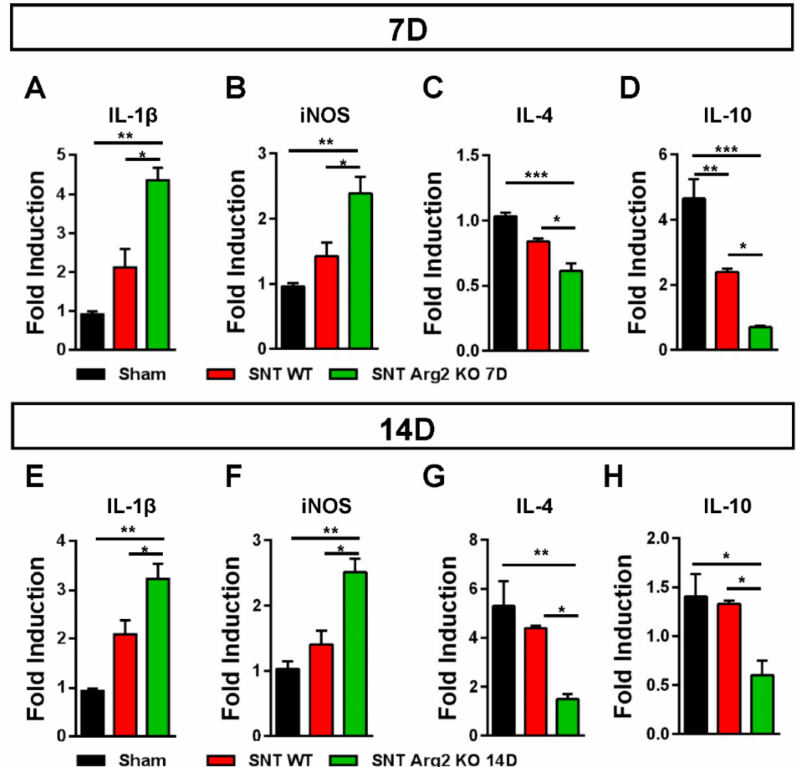
Figure 7. Regulation of inflammatory markers in the mice following the SNT surgery. ( A , B ) Gene expression levels of the pro-inflammatory markers interleukin (IL)-1 β and iNOS assessed by qRT-PCR indicated an upregulation of either IL-1 β or iNOS in the spinal dorsal horns of mice on day 7 after the SNT procedure. ( C , D ) In contrast, the levels of the anti-inflammatory markers IL4 and IL-10 on day 7 post-surgery were downregulated in the SNT ( n = 3 per group) mice. ( E – H ) Gene expression of these inflammatory markers were also assessed on day 14 post-surgery and obtained similar results. Data are presented as means ± SEM (one-way ANOVA with Tukey’s post hoc test, F (2,6) = 20.75 ( A ), F (2,6) = 14.68 ( B ), F (2,8) = 19.97 ( C ), F (2,6) = 31.68 ( D ), F (2,7) = 19.10 ( E ), F (2,6) = 17.75 ( F ), F (2,6) = 11.14 ( G ), F (2,6) = 7.734 ( H ). *** p < 0.001, ** p < 0.01, and * p < 0.05 versus